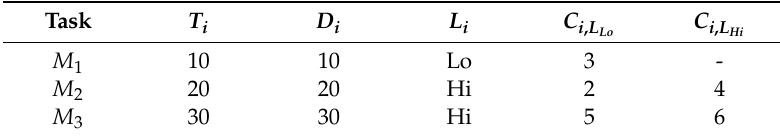
Table 1. Three-task set example.